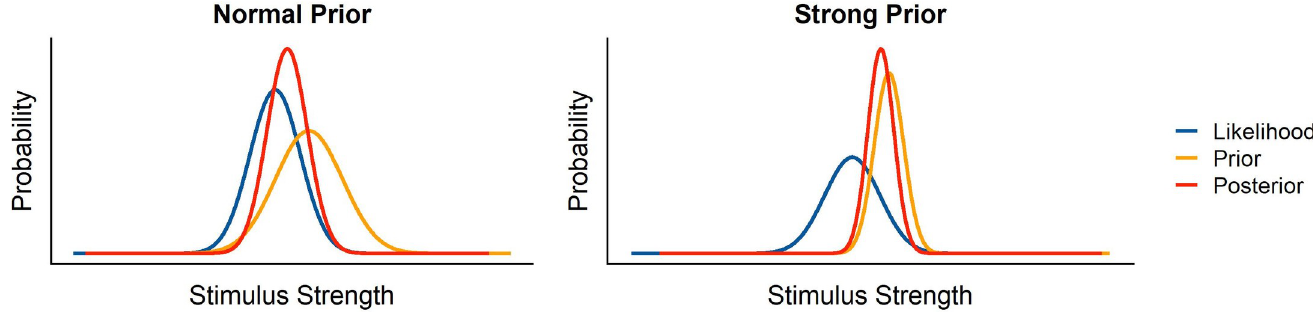
Fig 1. Graphical illustration of likelihood, prior and posterior in a Bayesian framework, for both a normal, relatively shallow prior, and a strong, extremely precise prior.